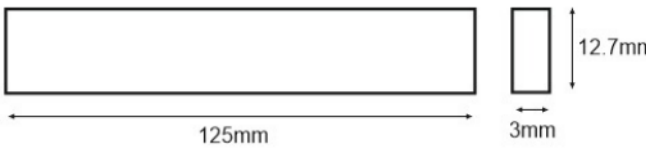
Figure 5. Flexural test specimen.